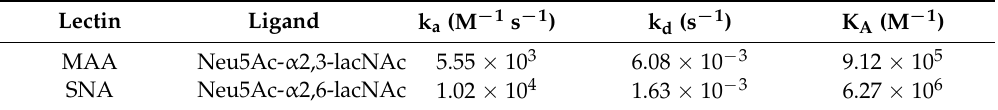
Figure 4. SPR sensorgrams of the two Sia-specific lectins at six different concentrations. ( a ) Binding of MAA to Neu5Ac- α 2,3-lacNAc glycoprobe; ( b ) Binding of SNA to Neu5Ac- α 2,6-lacNAc glycoprobe. Fitted curves are indicated as dotted black lines. Table 3. Kinetic constants of MAA and SNA to their specific sialic acid-containing glycoprobes determined by